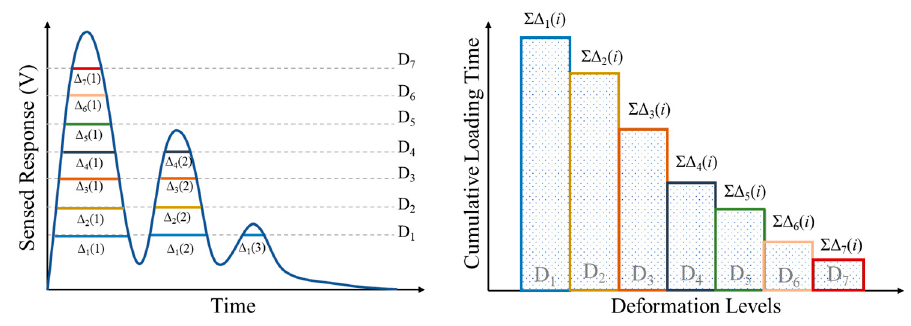
Figure 1. Representation of the data transformation and processing algorithm (redrawn from [9]).